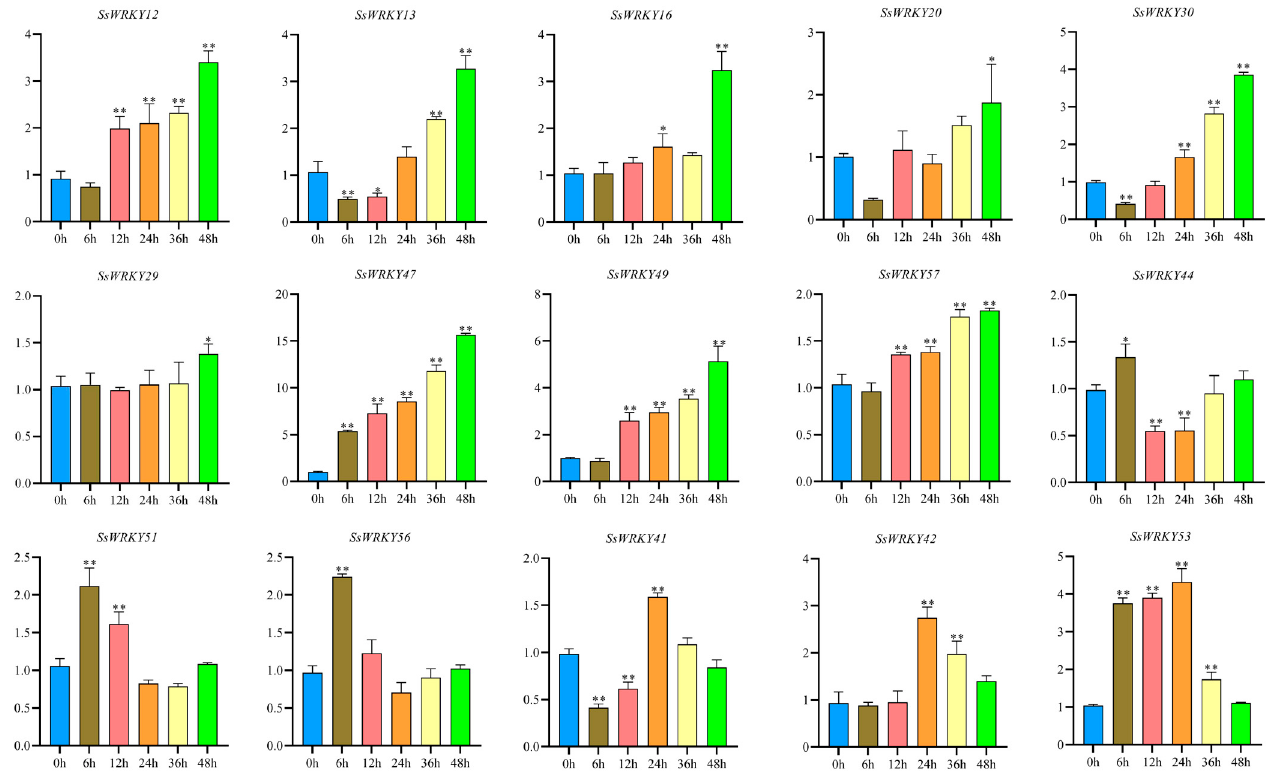
Figure 9. qRT-PCR analysis of SsWRKY genes under cold stress. The Y-axes represent the relative expression and X-axes represent the duration of the cold treatment. Data represents the mean ± SD of three technical repetitions.* p < 0.05, ** p < 0.01.